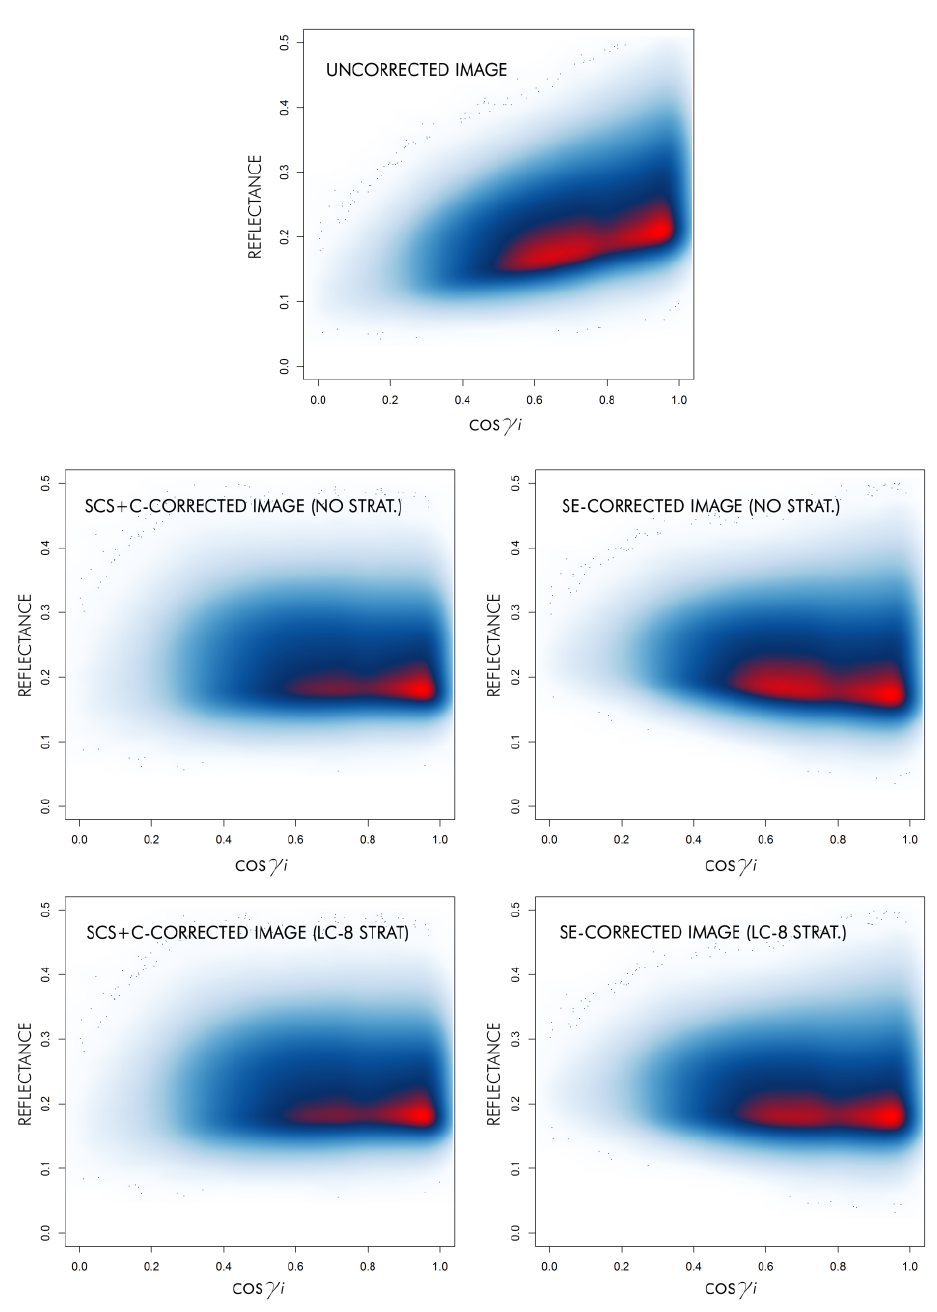
Figure 7. Scatterplot of the spectral reflectance of band 3 (NIR) for forest strata versus the cosine of solar incidence angle.